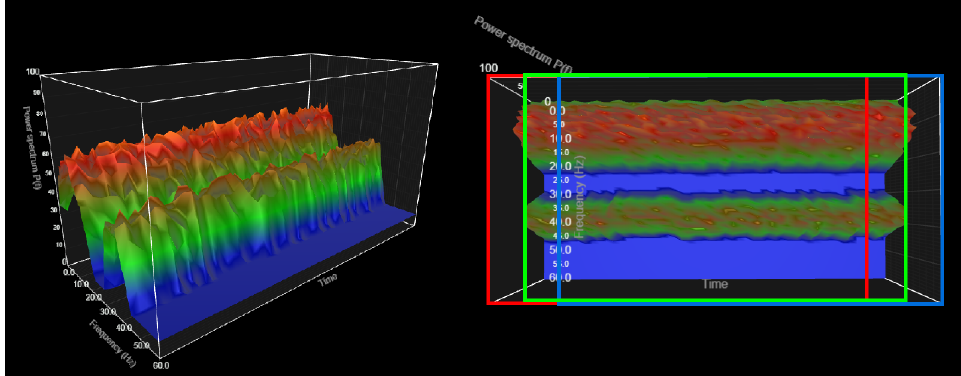
Figure 5. Lighting-chart-based simulation plots to help understand the key idea of the multi-time- scale